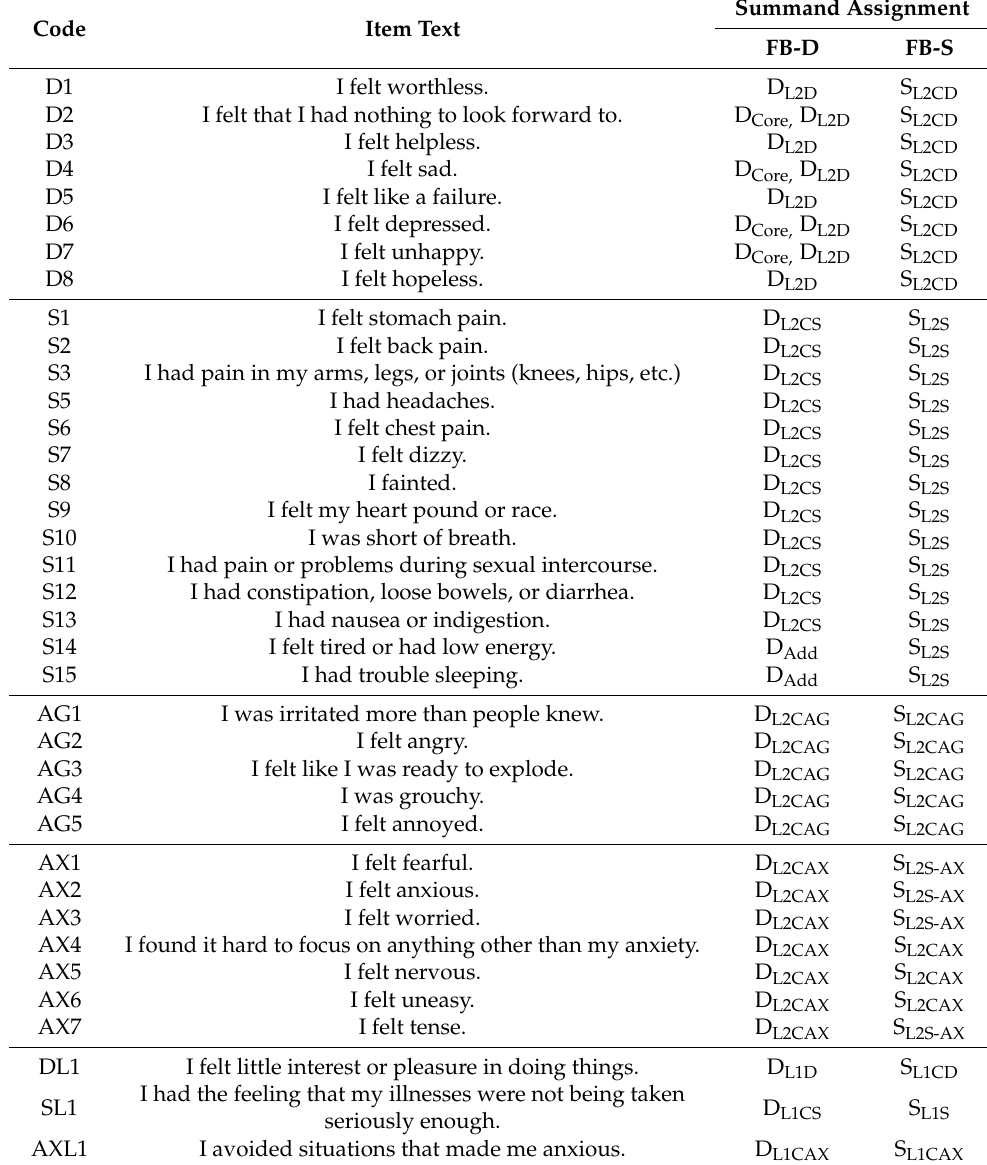
Table 2. Psychological health